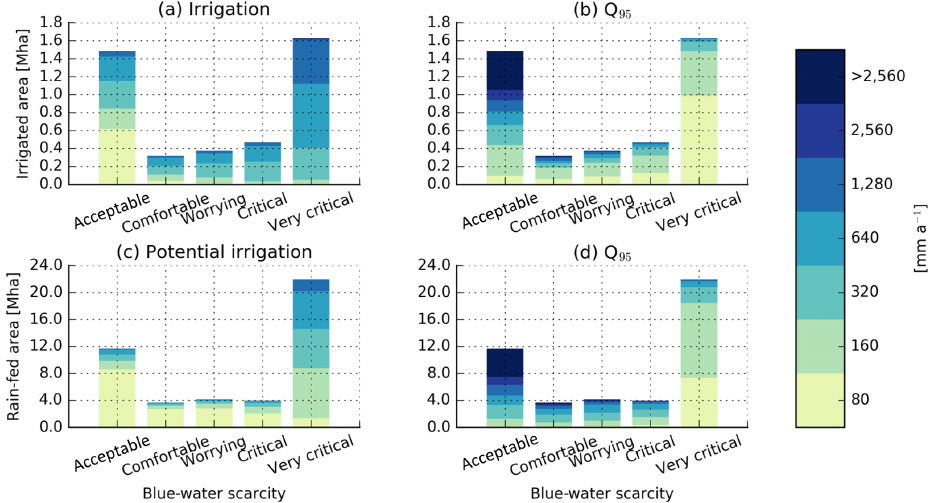
Figure 3. Classification of blue-water consumption (a, c) and blue-water availability (b, d) for irrigated areas ( a, b ; 4.29Mha) and potential irrigated areas ( c, d ; 45.56Mha) according to blue-water scarcity